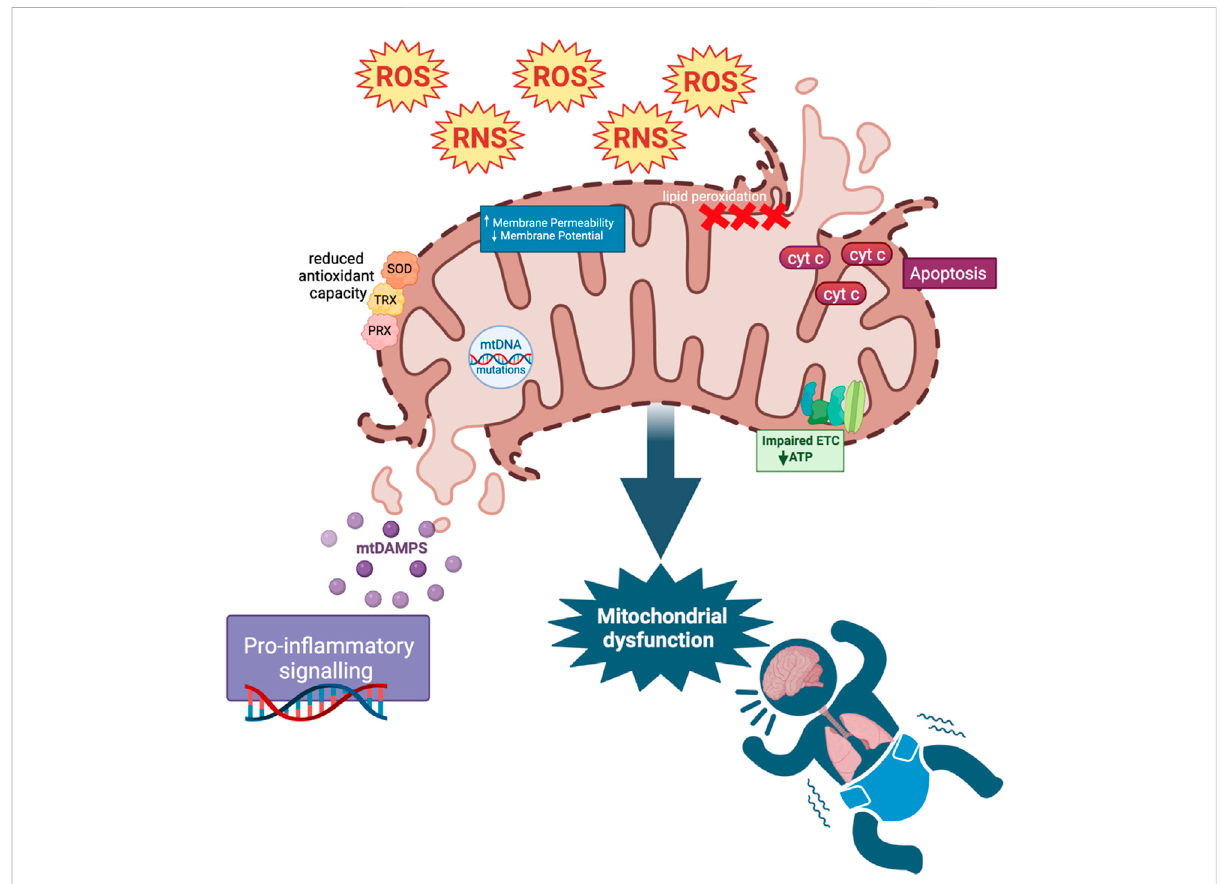
FIGURE 1 ROSandMitochondrialdysfunction.IncreasedROSandRNScausemitochondrialdysfunctionthroughmitochondrialDNA(mtDNA)mutations, defects in the electron transport chain (ETC) and antioxidant modulatory proteins, and lipid peroxidation in cell and mitochondrial membranes (affecting mitochondrial membrane potential). These changes in mitochondrial permeability could lead to the release of cytochrome C (cyt